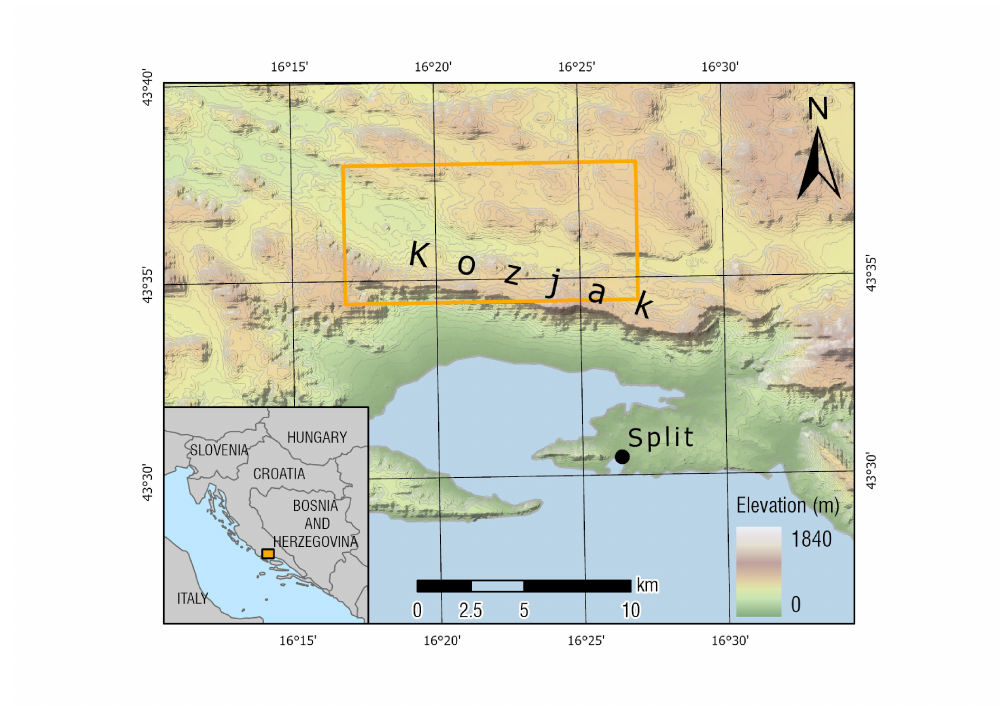
Figure 1: The northern slope of the Kozjak Mountains in the Republic of Croatia was se- lected as the study area for this study. The orange rectangle indicates the spatial extent of the results shown in Figure